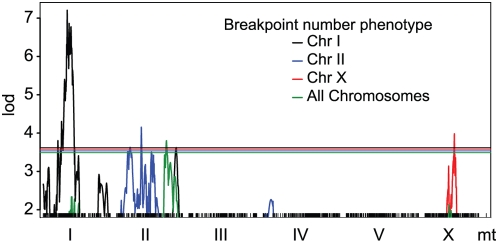
Breakpoint counts exhibit linkage to genomic intervals.Lod scores from nonparametric interval mapping are plotted as a function of genetic position for the four breakpoint count traits that exhibit significant linkage. Horizontal lines represent trait-specific genome-wide significance thresholds (p = 0.05) estimated by structured permutation.